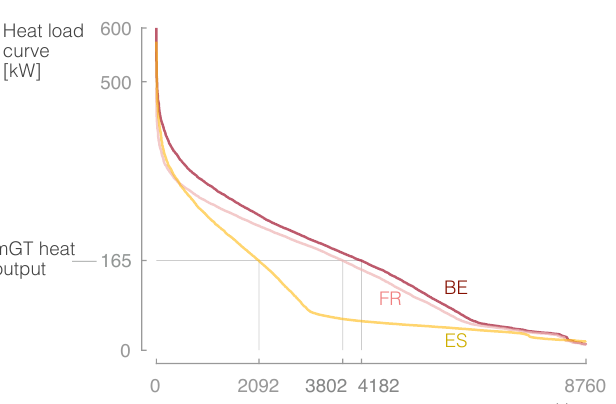
Figure 10. Heat load curves of mGT and mHAT in the three countries. Due to the sizing methodology, the number of working hours at full load in Spain are substantially lower than in Belgium or France.